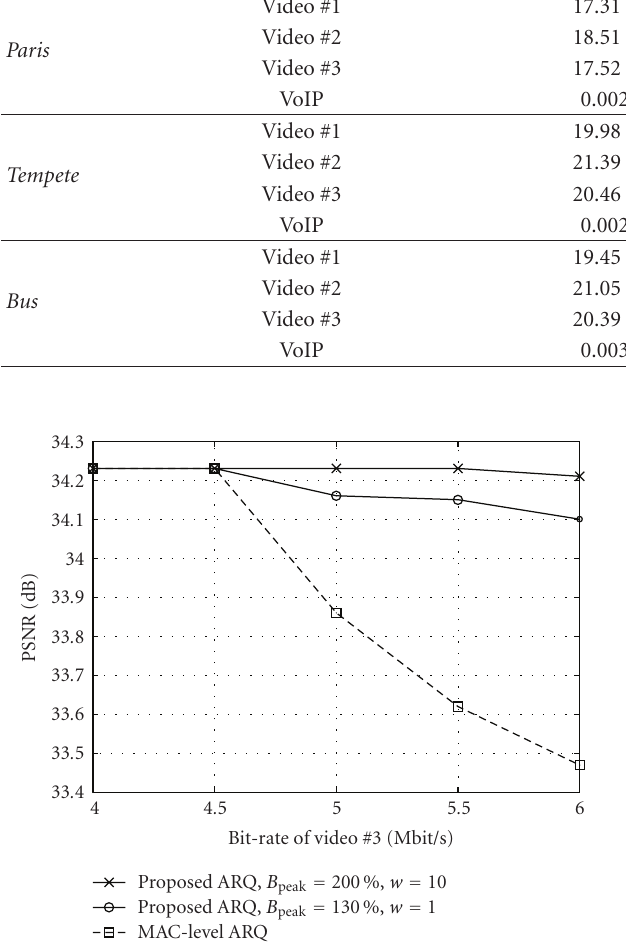
Figure 15: PSNR as a function of channel noise for both the MAC- level ARQ and the proposed ARQ scheme; bus